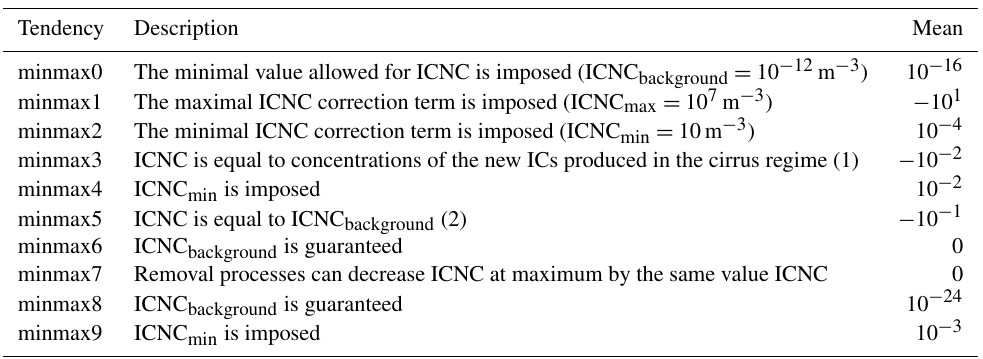
Table 2. Numerical ICNC tendencies defined in the CLOUD submodel. The third column shows the order of magnitude (in m − 3 s − 1 ) of the global means computed with the REF simulation. In the second column, (1) indicates “when cloud cover > 0, cloud ice > 10 − 12 kgkg − 1 , and ICNC < ICNC min is true”, and (2) indicates “when cloud cover > 0 and cloud ice > 10 − 12 kgkg − 1 is false”. Tendency